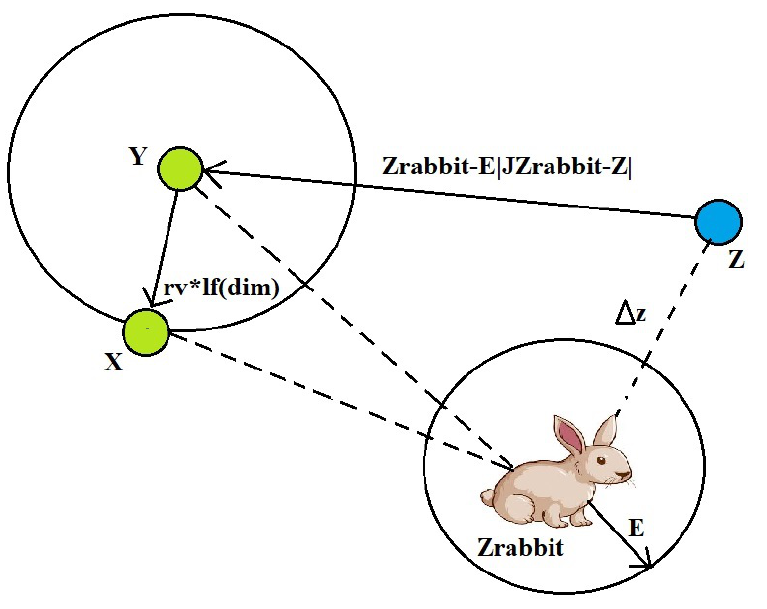
Figure 6. In the scenario of a soft besiege with progressive speedy dives, a sample of overall